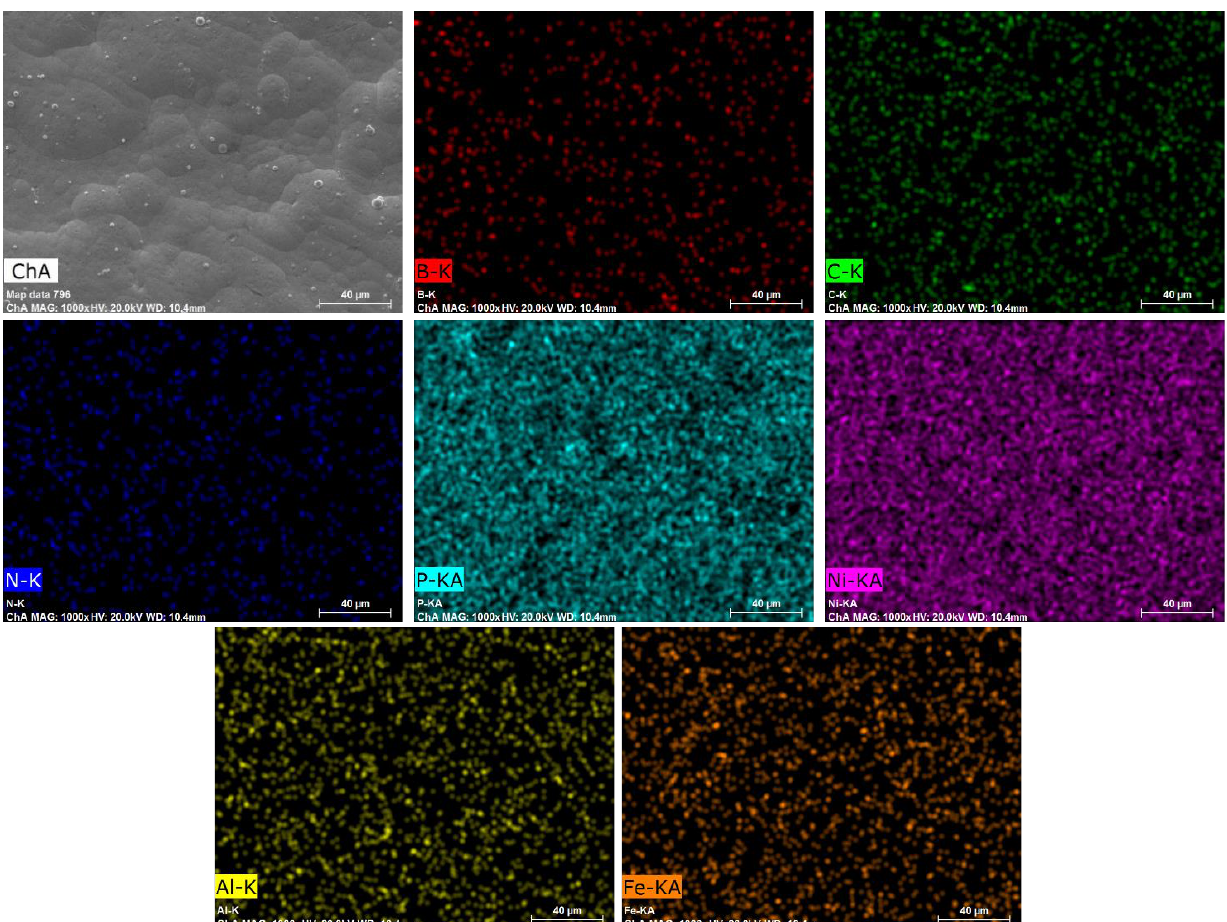
Figure 5. EDS mapping of composition of the rectangular area marked in Figure 4.